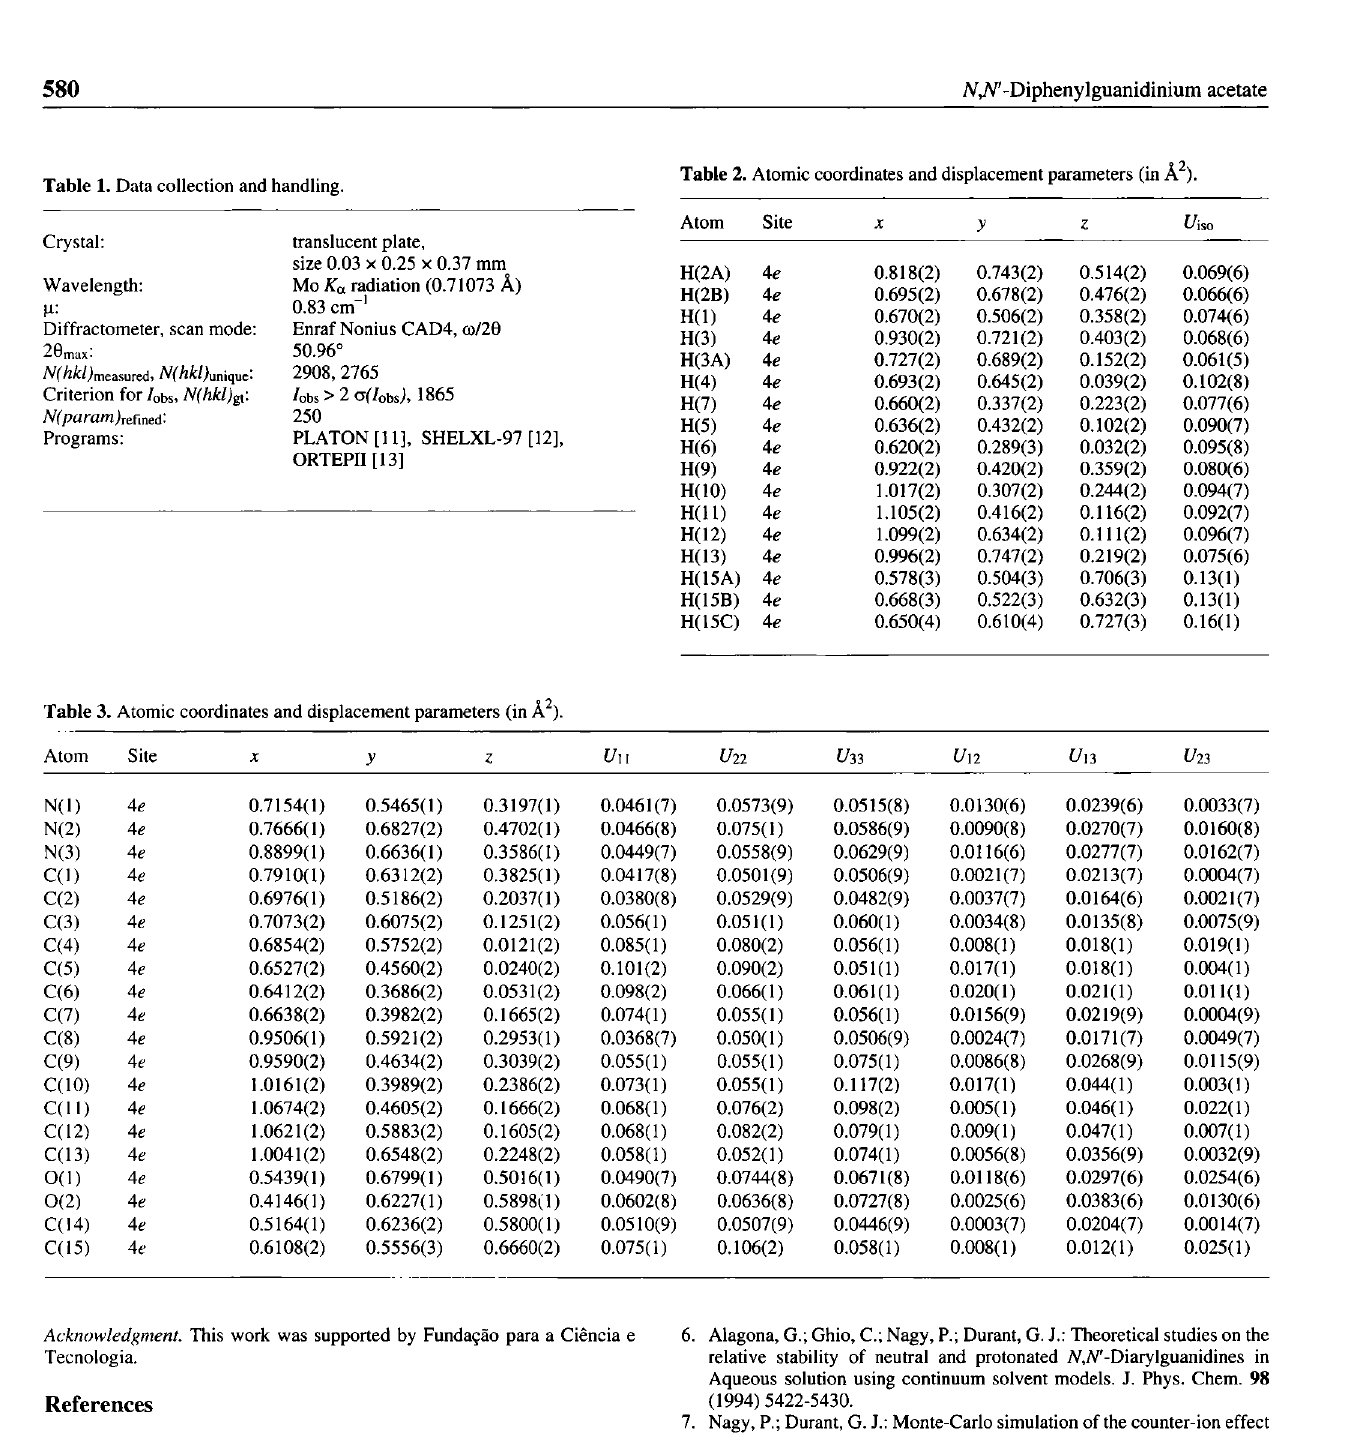
Table 2. Atomic coordinates and displacement parameters (in À 2 ).